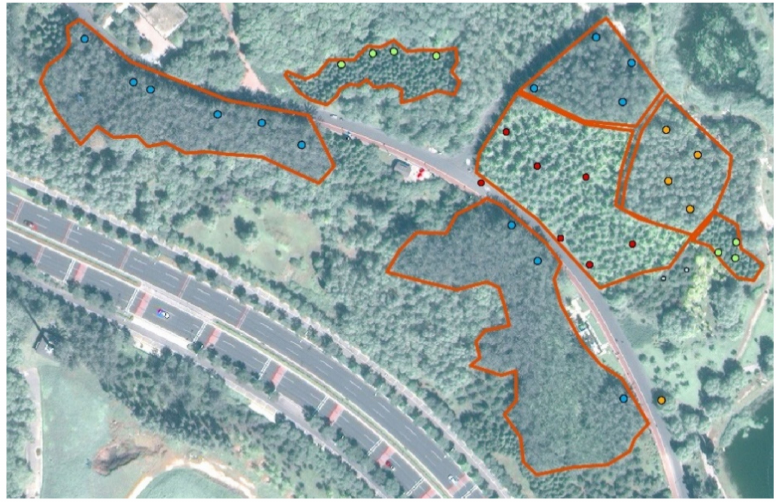
Figure 2. Example of marked investigation zones and located global positioning system (GPS) points.